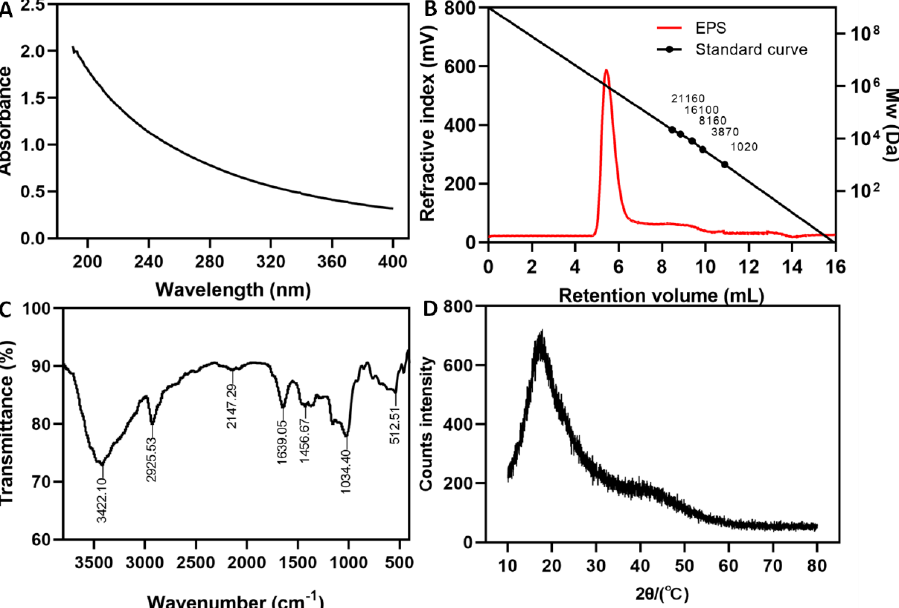
Figure 2. The purity and structural characteristics of dextran. ( A ) UV-vis spectrum; ( B ) GPC chro- matogram; ( C ) Fourier transform infrared (FT-IR) spectrum; ( D ) X-ray diffraction (XRD)